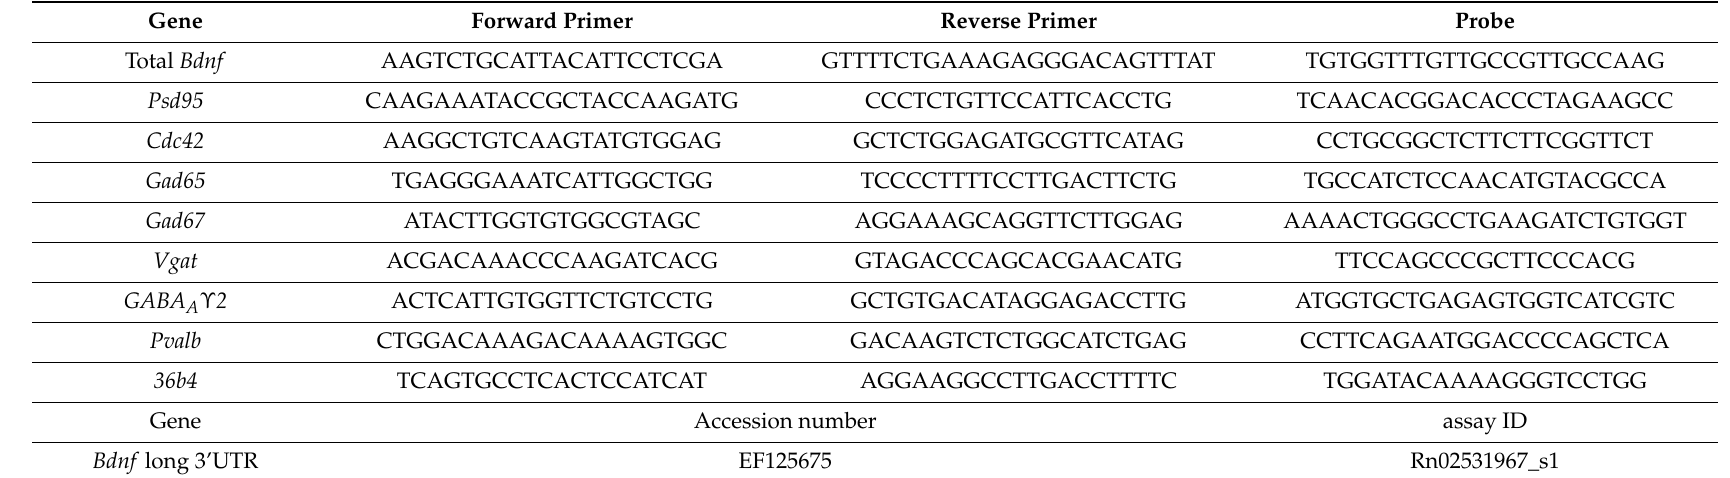
Table 1. Forward and reverse primers and probes sequences used in real-time polymerase chain reaction (RT-PCR) analyses, acquired from Eurofins MWG-Operon or from Life Technologies, which does not reveal the sequences.